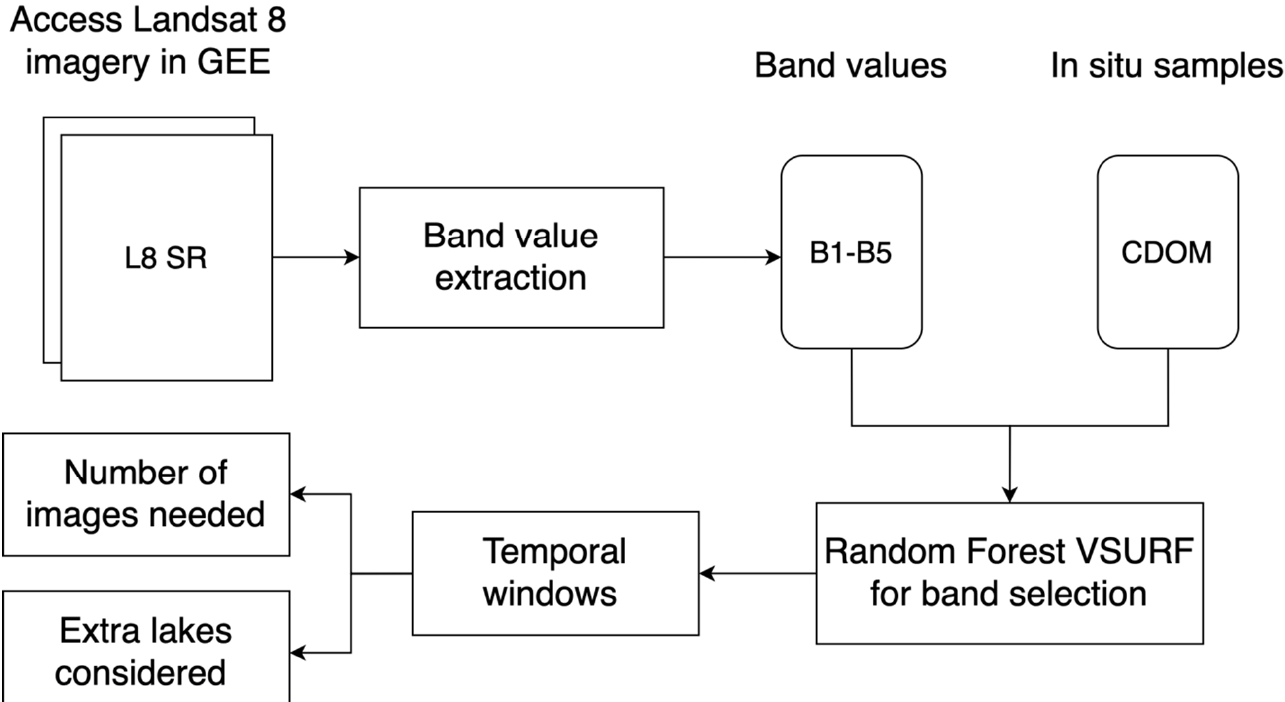
Figure 2. Overview of the main steps included in the methodology.